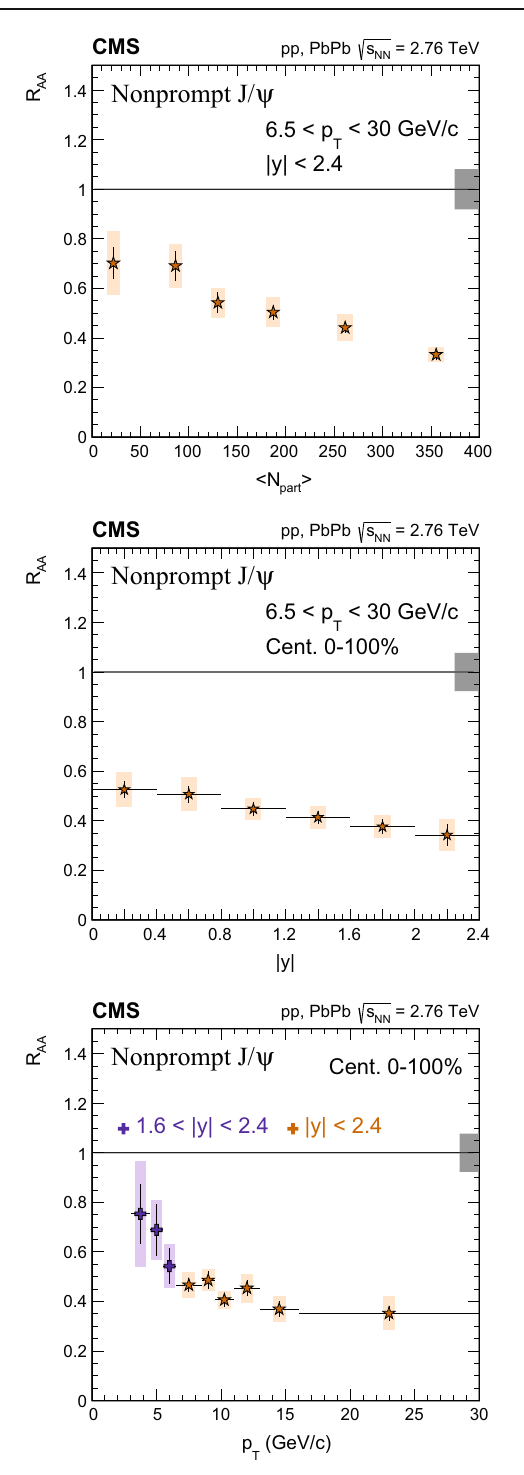
Fig. 7 Nonprompt J /ψ R AA as a function of centrality ( top ), rapidity ( middle ), and p T ( bottom ). The bars ( boxes ) represent statistical (sys- tematic) point-by-point uncertainties. The gray boxes plotted on the right side at R AA = 1 represent the scale of the global uncertainties. For R AA vs. N part , the average N part values correspond to events flatly distributed across centrality